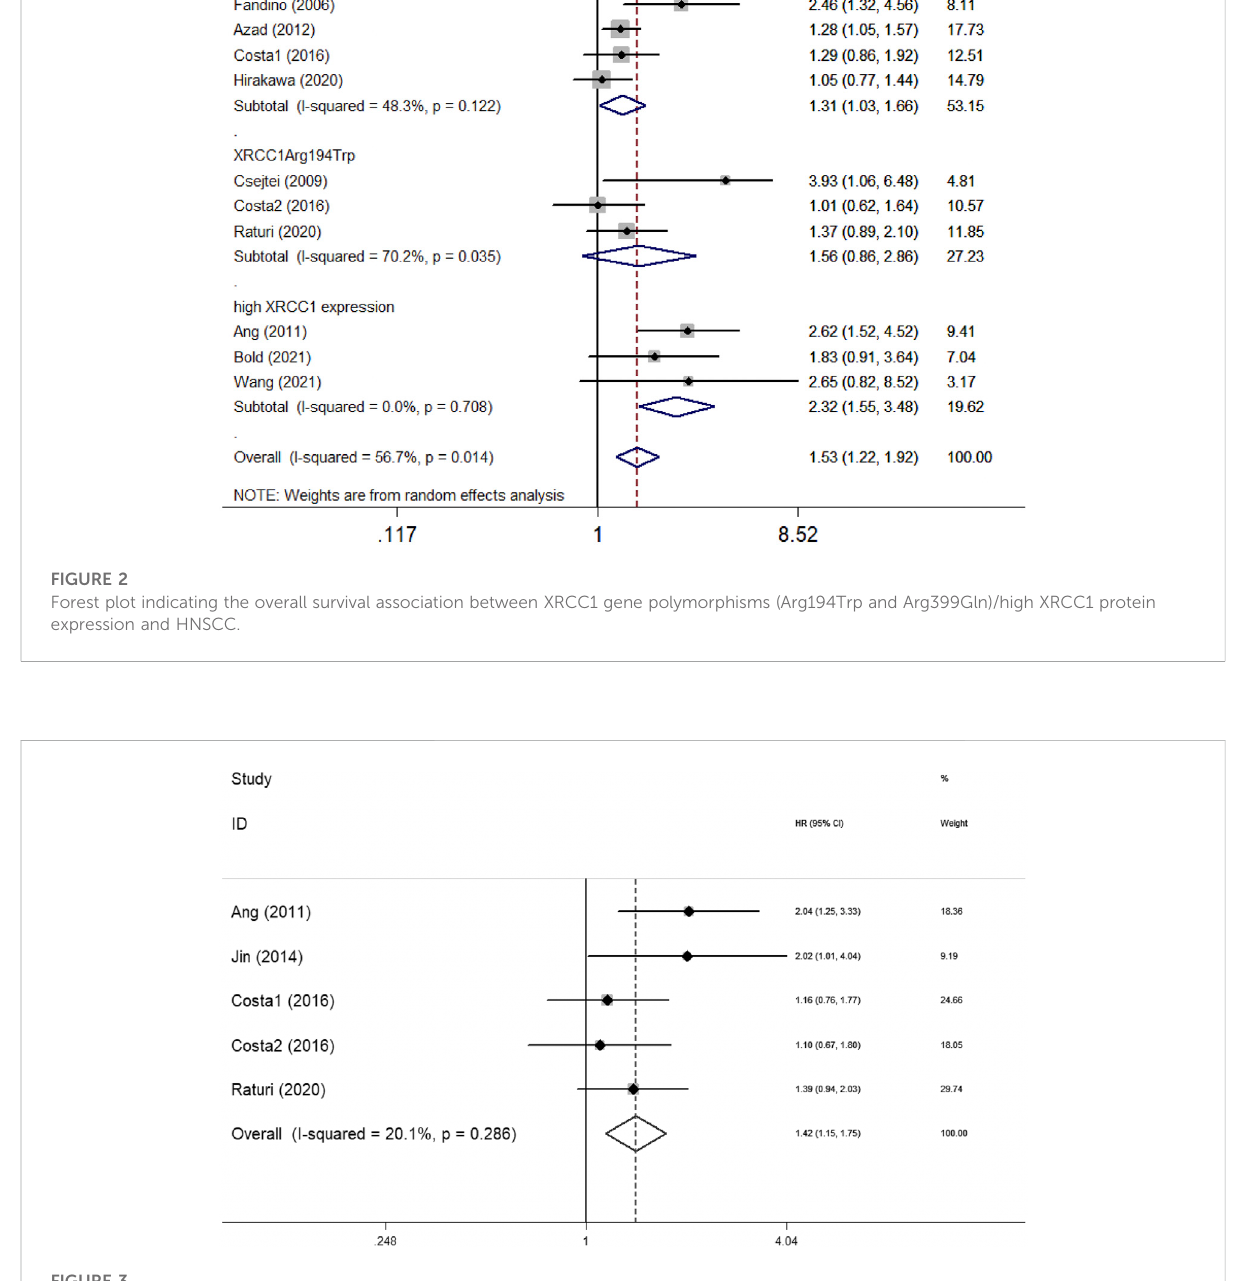
FIGURE 3 Forest plot indicating the association between XRCC1 and progression-free survival in